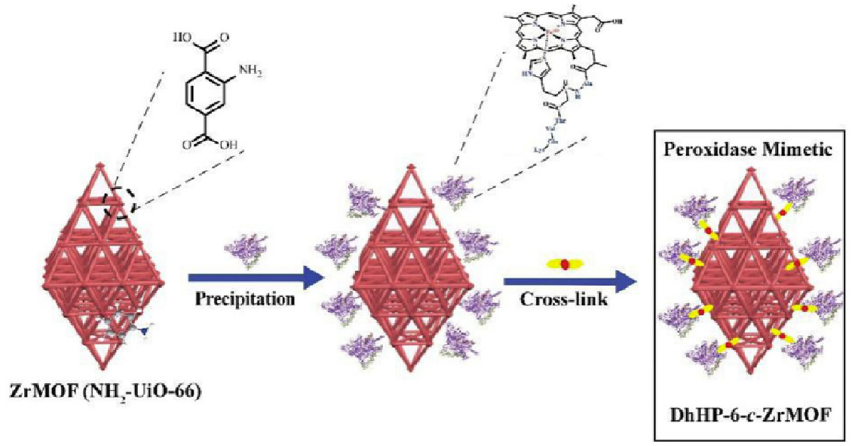
Figure 26. Schematic illustration of the synthesis of DhHP- c -ZrMOF. (Reprinted with permission from [189]. Copyright © 2019 Elsevier B.V. All rights reserved).